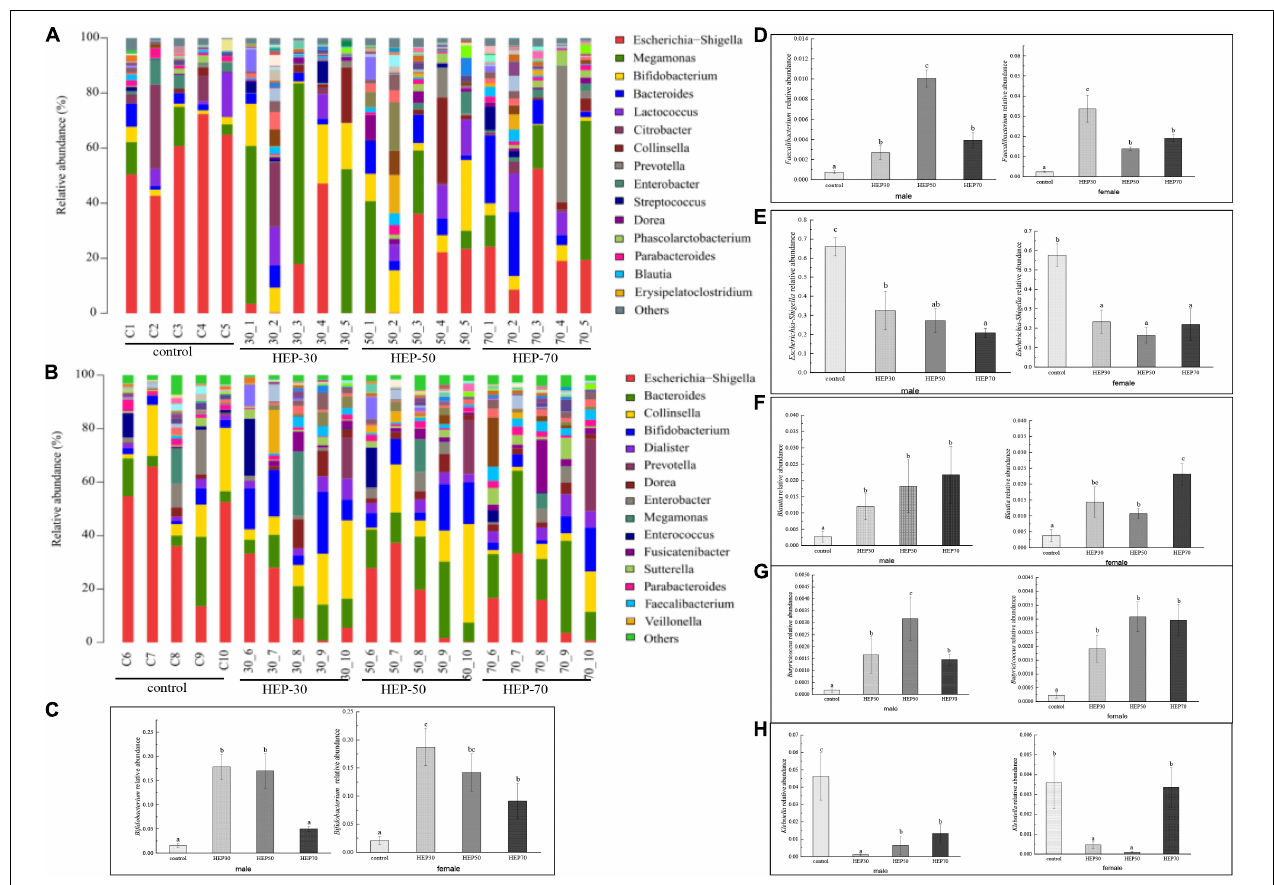
FIGURE 8 | Effects of HEPs on the gut microbiota structure at the genus level. The 15 most abundant at the genus level in male (A) and female (B) ; (C) , Bifidobacterium ; (D) , Faecalibacterium ; (E) , Escherichia-Shigella ; (F) , Blautia ; (G) , Butyricicoccus ; (H) , Klebsiella. Data are means ± SD (5 independent experiments). a , b , c Different letters (without a common letter) indicated a significant difference between the two groups ( p <